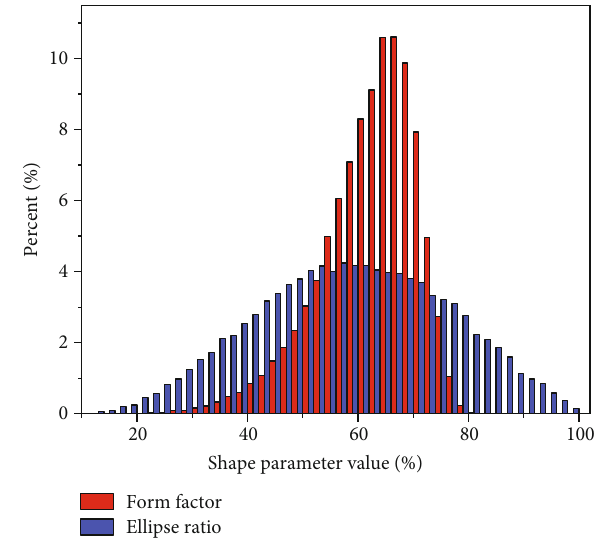
Figure 8: Experimental data and the fi tting curve of RR distribution (cumulative distribution).